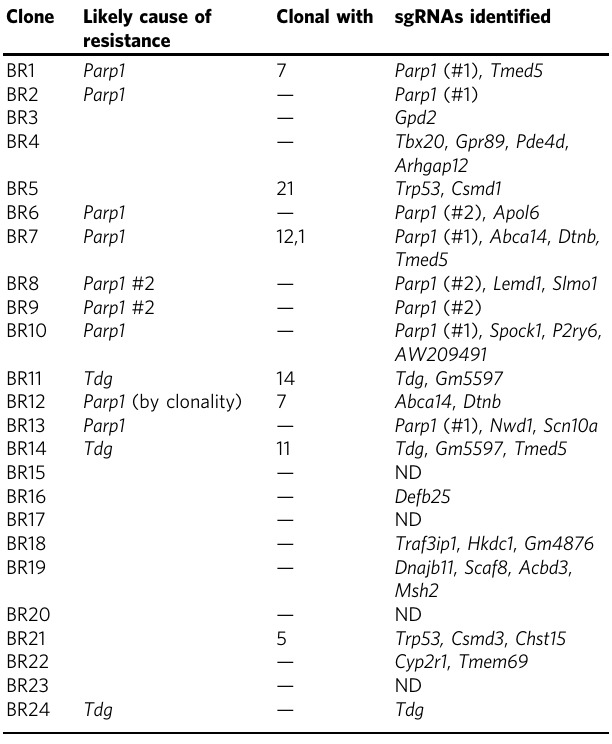
Table 1 Results of sequencing sgRNA PCR products from talazoparib-resistant mouse ES cell clones isolated from the CRISPR screen described in Fig.